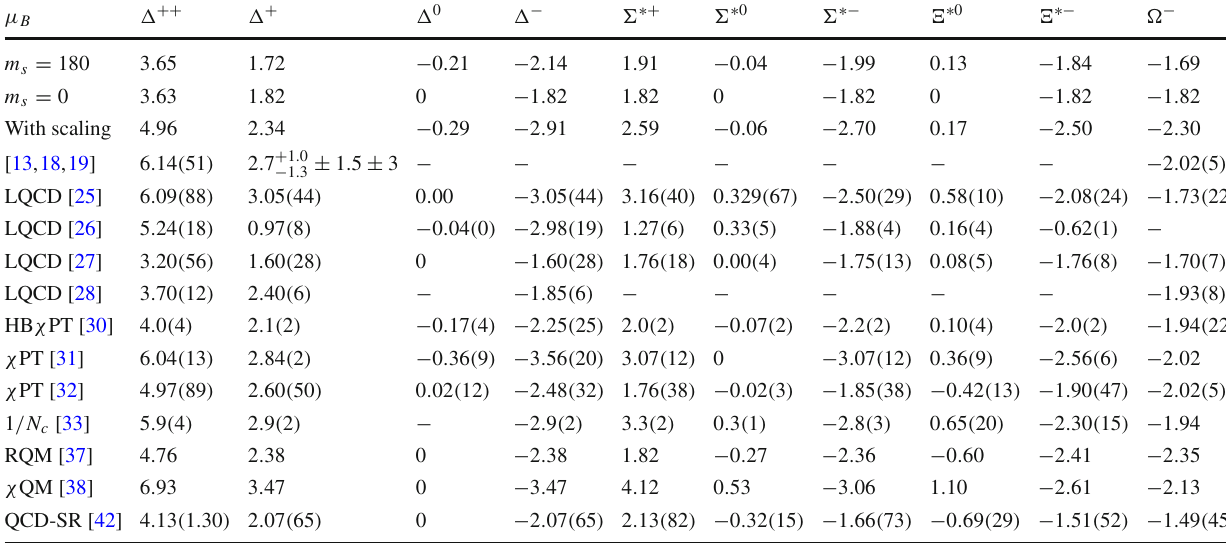
Table 2 Magnetic dipole moments of the baryon decuplet in compar- ison with the results from lattice QCD [25–28], the relativistic quark model [37], next-to-leading-order HB χ PT [30], large N c [33], QCD